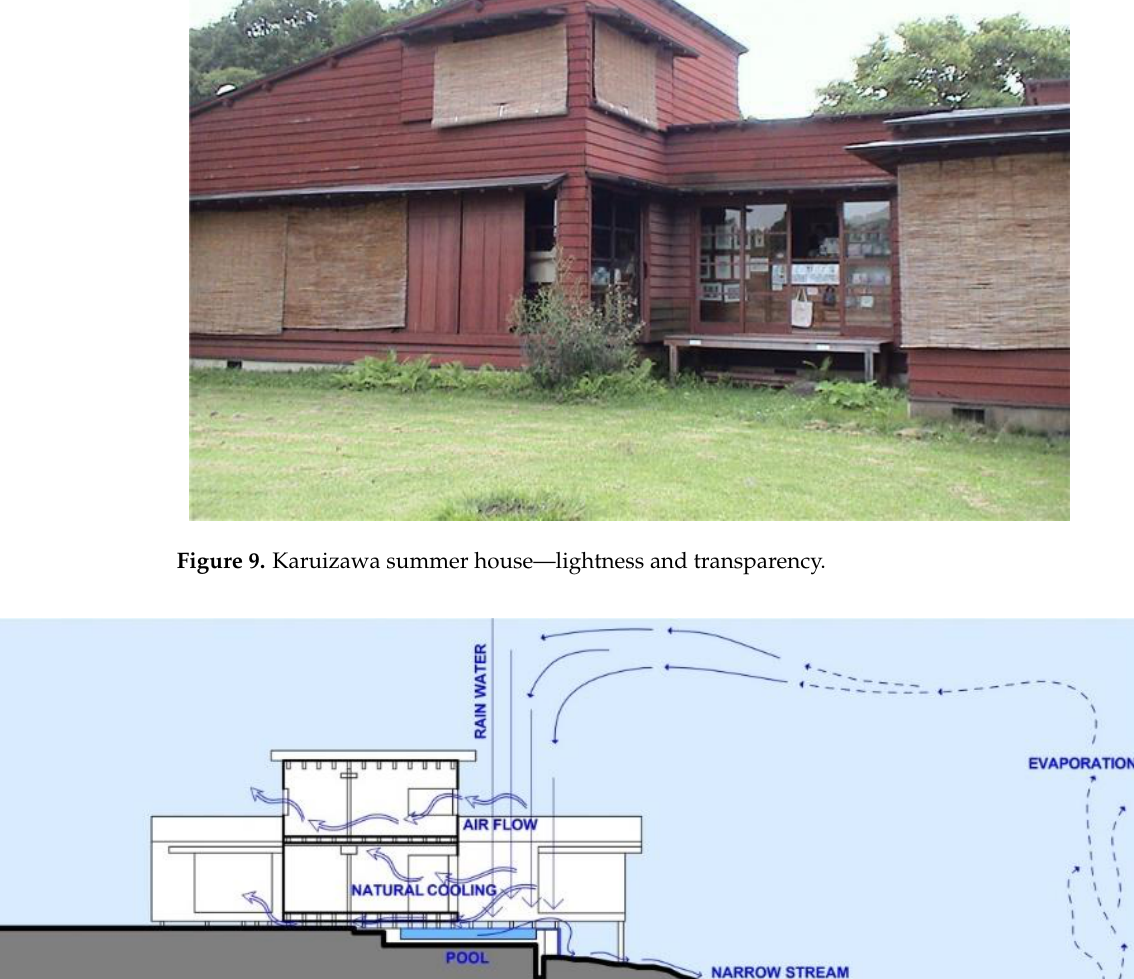
Figure 10. Karuizawa summer house — section, natural ventilation and water cycle = eco-friendly, sustainable house.